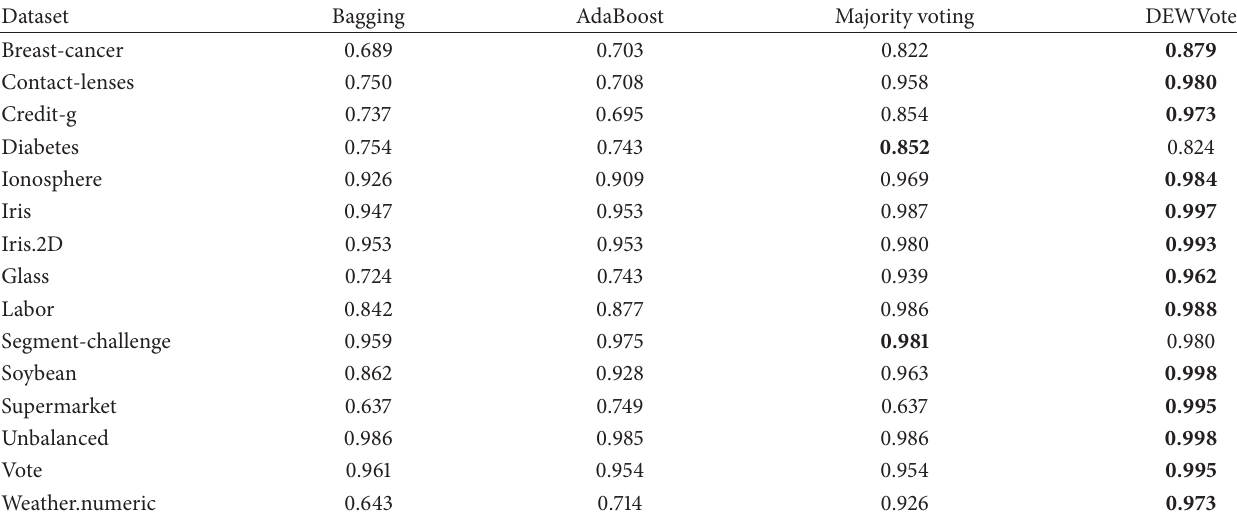
Table 3: Comparison of 4 ensemble